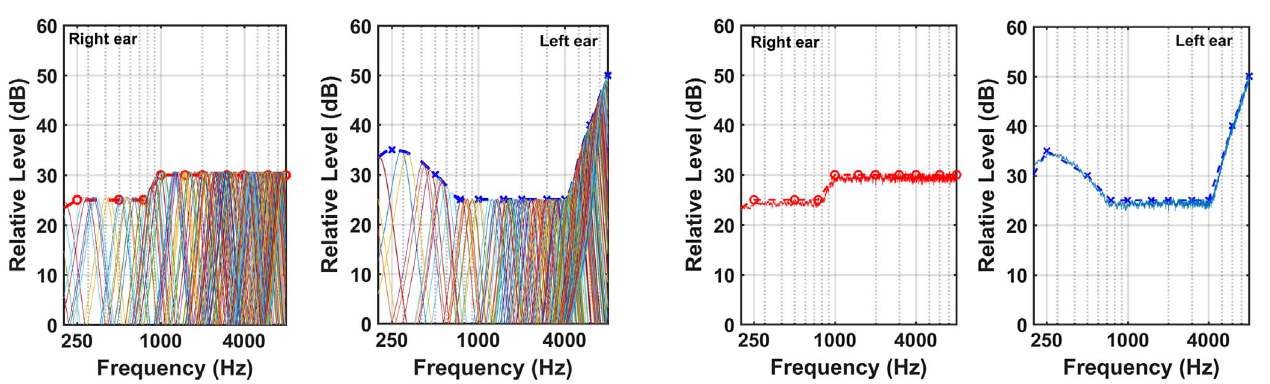
Figure 6. Log-spectra of the right and left tone-pips sequences superimposed to the HL curves.